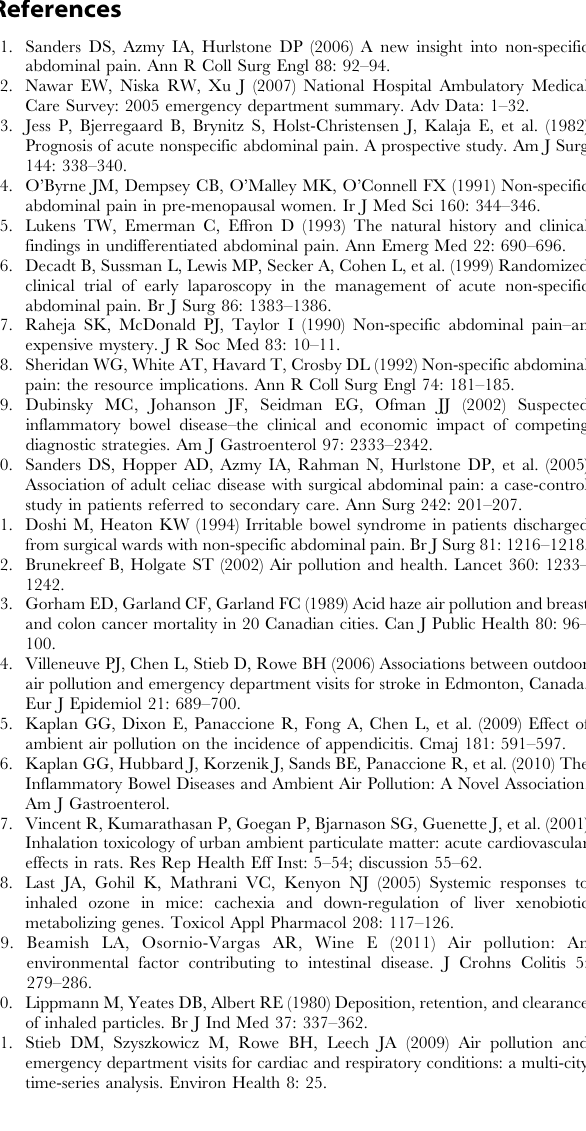
Table S4 Odds ratio for presenting to an